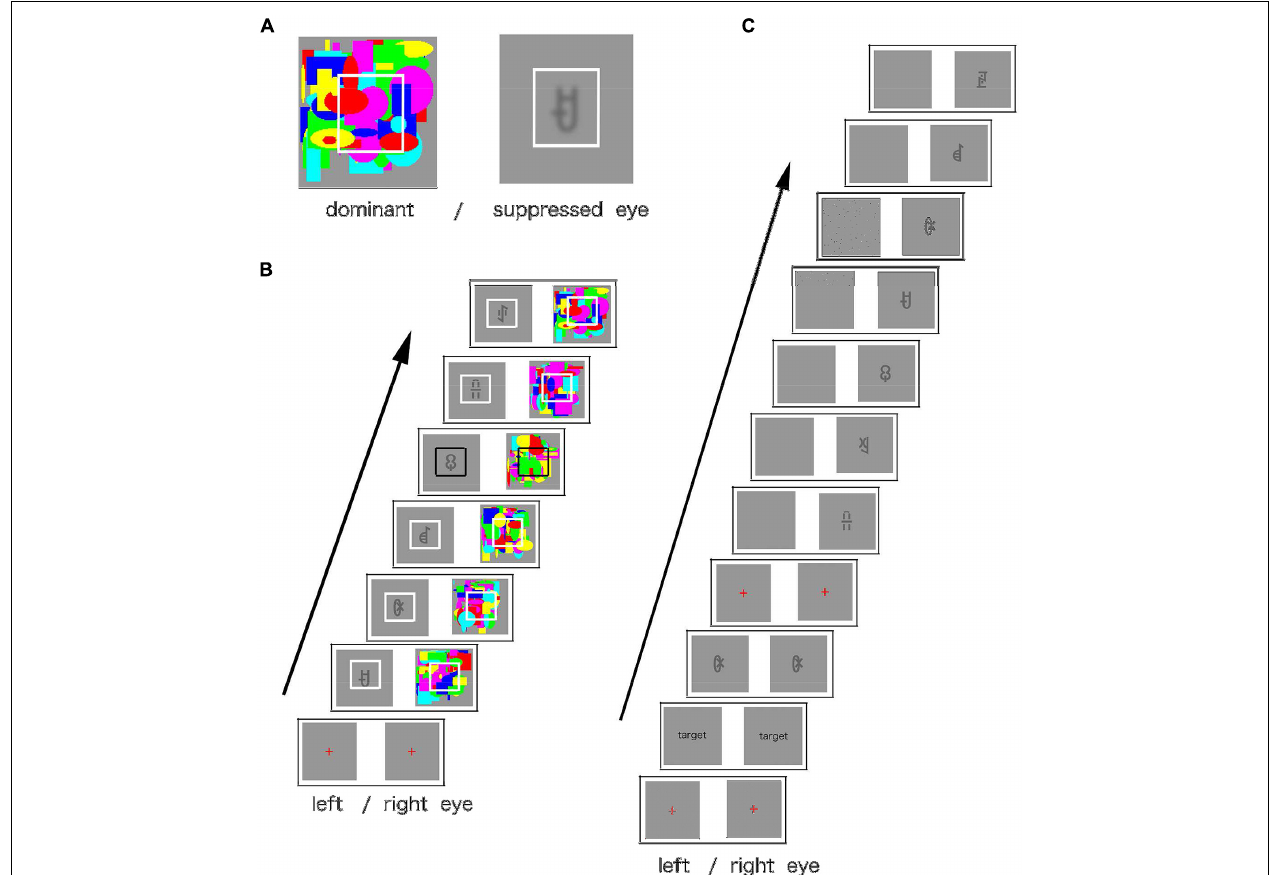
FIGURE 2 | (A) An example of stimulus configuration. Participants saw the display through a stereoscope. A random flash pattern was presented to one eye (dominant eye), and a symbol (Yi script) was presented to the other eye (suppressed eye).White frames were presented to both eyes to aid the eyes’ convergence. (B) The sequence of stimuli in the familiarization phase.The symbols were updated every 400 ms, and the flash stream was updated every 200 ms. Participants were instructed to press the space key when the white frame turned black. (C) The sequence of the stimuli in the test